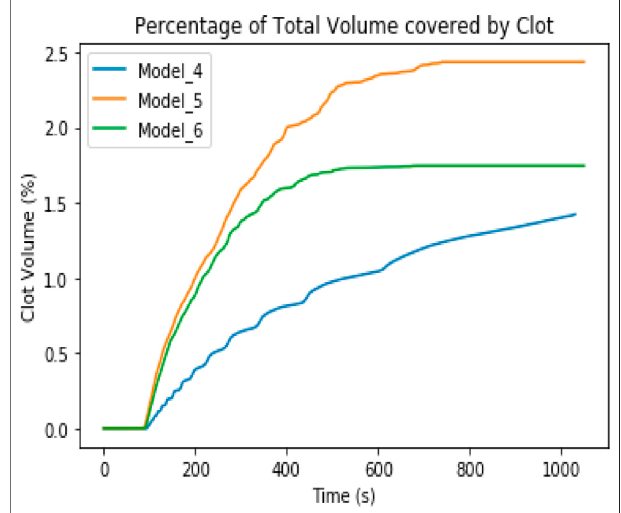
FIGURE 8 | Comparison of the percentage of total volume covered by the clots in Models_4, 5, and 6 (three-dimensional